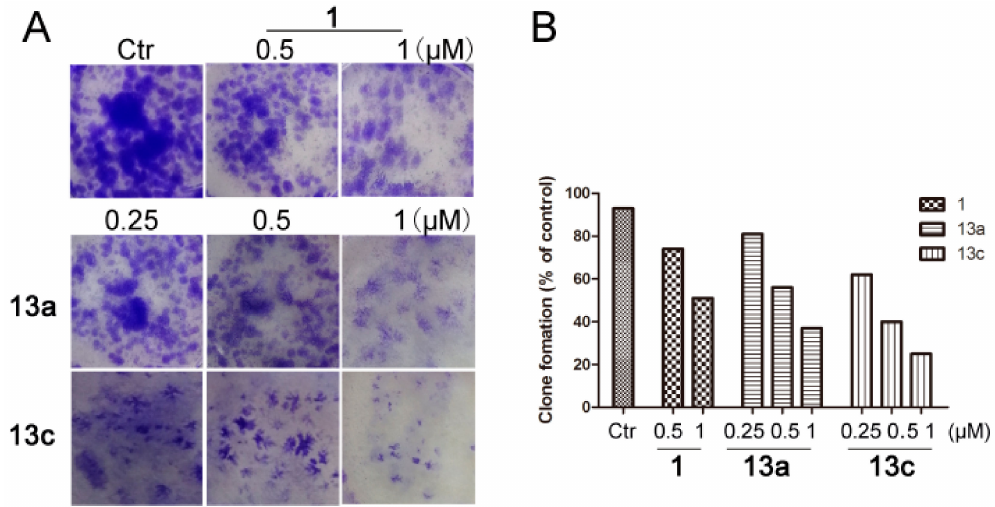
Figure3. Compounds 13a and 13c inhibitedthecolonyformationofMDA-MB-231cells. ( A )Compounds inhibited the colony formation of MDA-MB-231 cells. After treatment with di ff erent concentrations of 13a , 13c and SAHA in six-well plates for seven days, cells were fixed with methanol and stained with 1% crystal violet and the number of cell clones was counted. ( B ) Quantitative